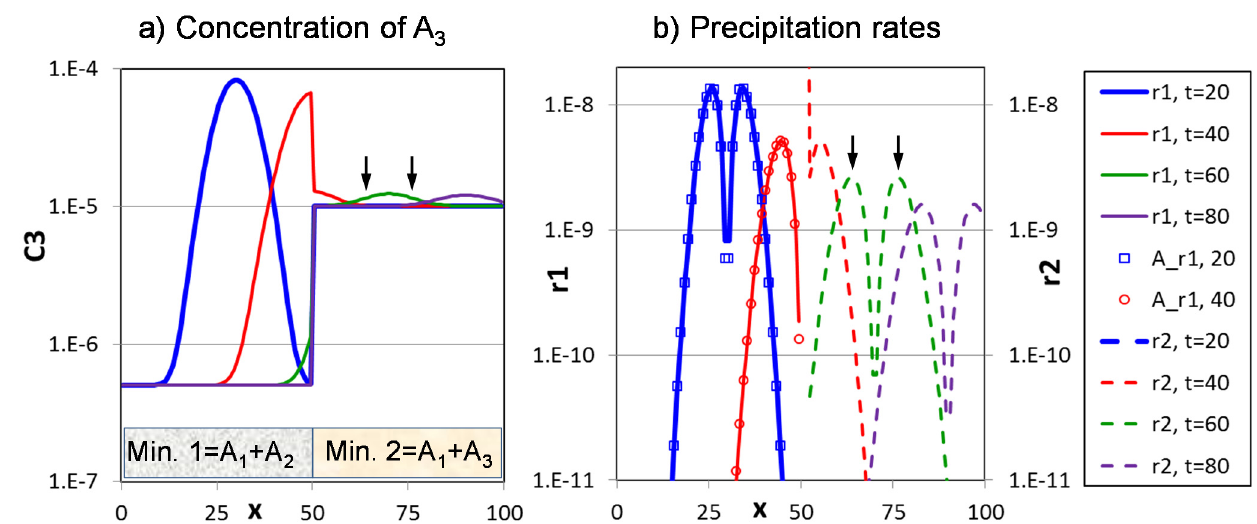
Figure 6. Transport of pulse injected at x = − 8 m and t = − 18 d in a medium consisting of two minerals. A front occurs for A 3 at x > 50 m, where it equilibrates with Min. 2, causing its sharp precipitation and an apparent discontinuity in concentrations. The analytical solution (A_r1) [73] is displayed for the precipitation rate of Min. 1. Reaction rates maxima coincide with gradients maxima (black arrows).